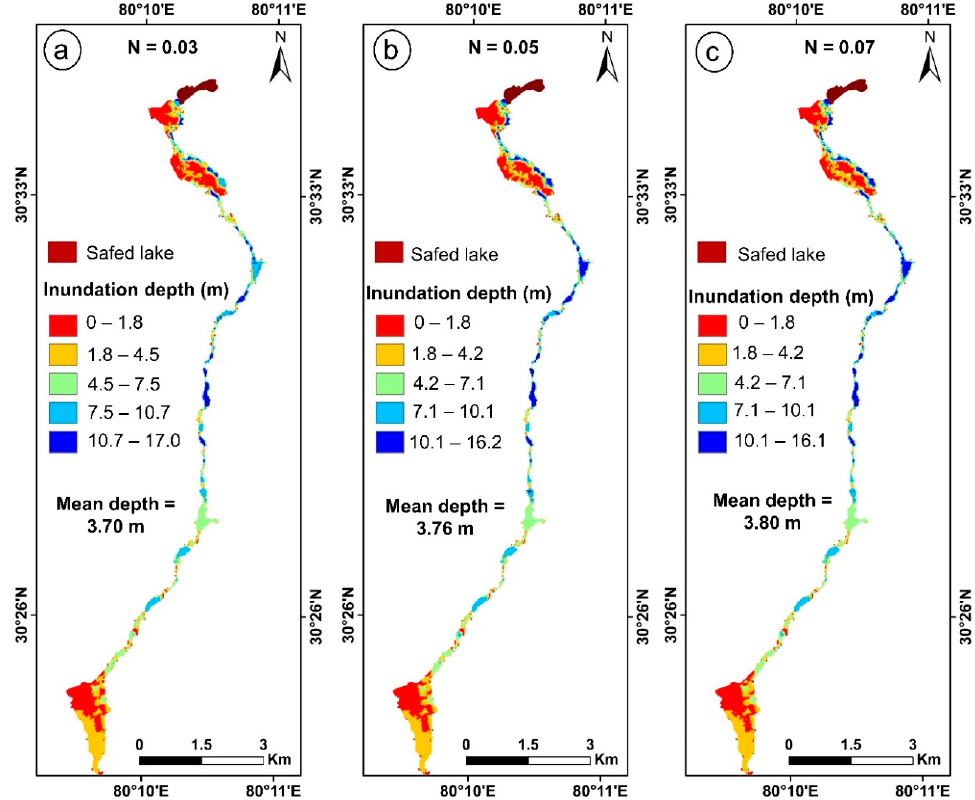
Figure 10. Spatial distribution of maximum inundation depth along the channel from Safed Lake to Milam village for varied Manning’s N—( a ) N = 0.03; ( b ) N = 0.05; ( c ) N = 0.07.